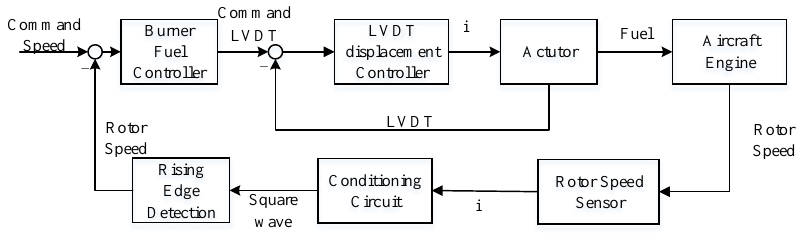
Figure 8. Aero-engine controller diagram.